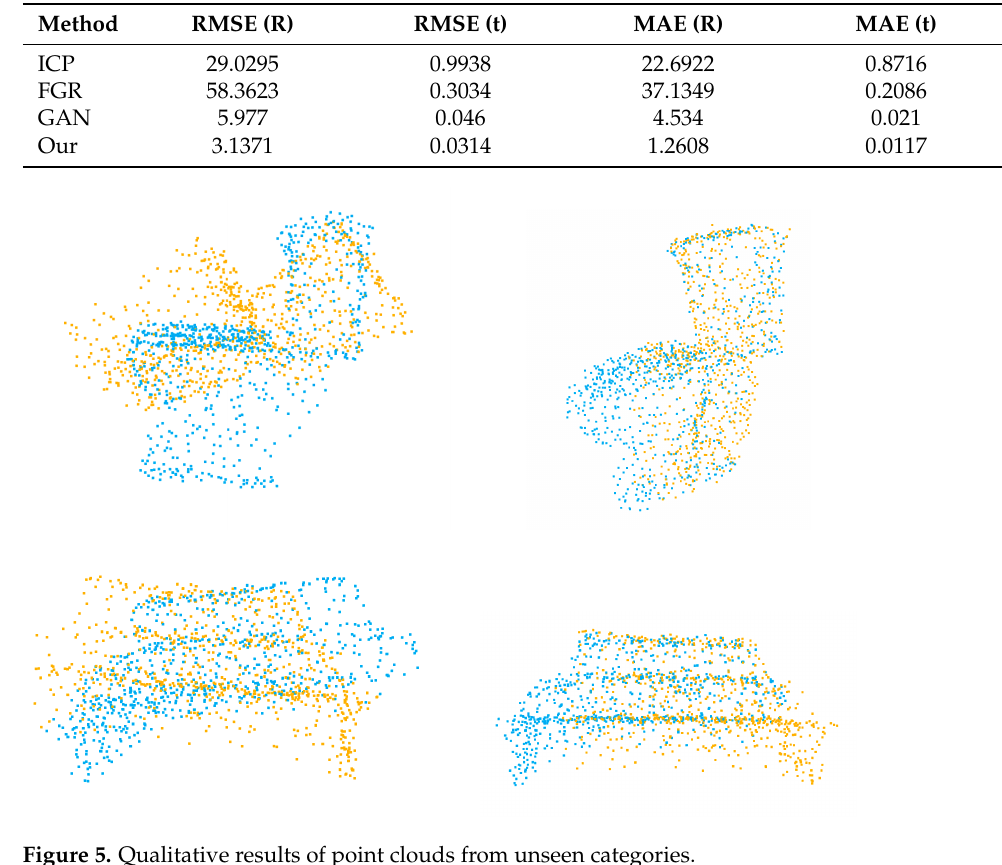
Figure 5. Qualitative results of point clouds from unseen categories.